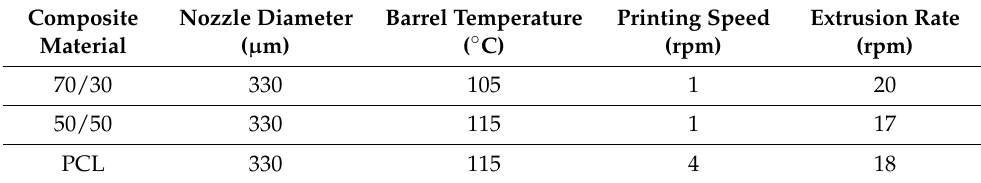
Table 1. Scaffold printing parameters for 70/30, 50/50, and pure PCL